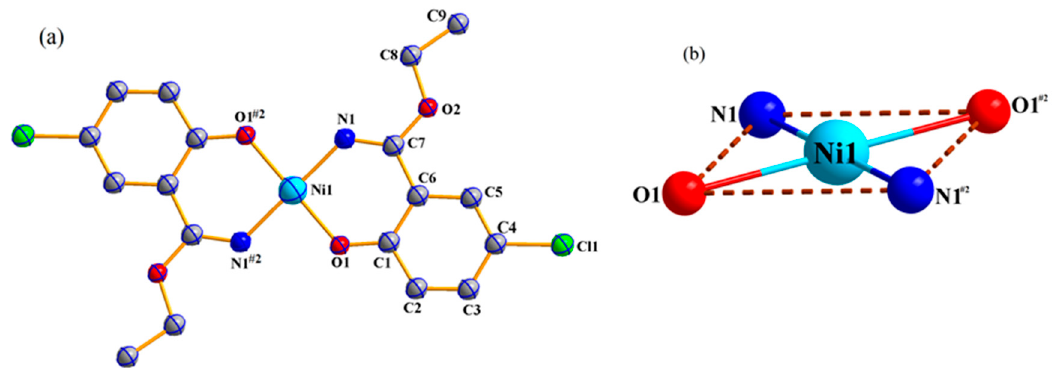
Figure 7. ( a ) Molecular structure and atom numberings of coordination compound 2 with 30% probability displacement ellipsoids (hydrogen atoms are omitted for clarity); ( b ) Coordination polyhedra for Ni(II) atoms of coordination compound 2 . Crystals 2018 , 8 , 43